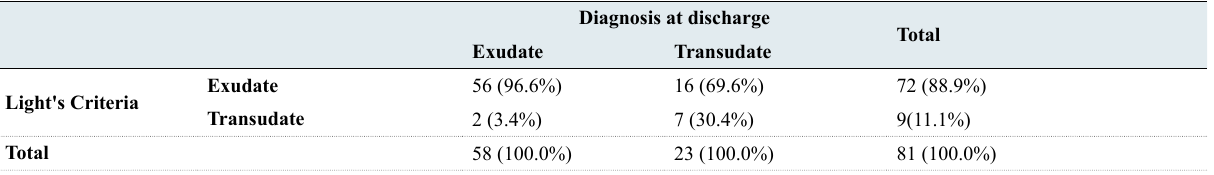
*Lymphadenopthy; ** Jugular venous pressure Table 2: Relationship between Light’s criteria and diagnosis on discharge.